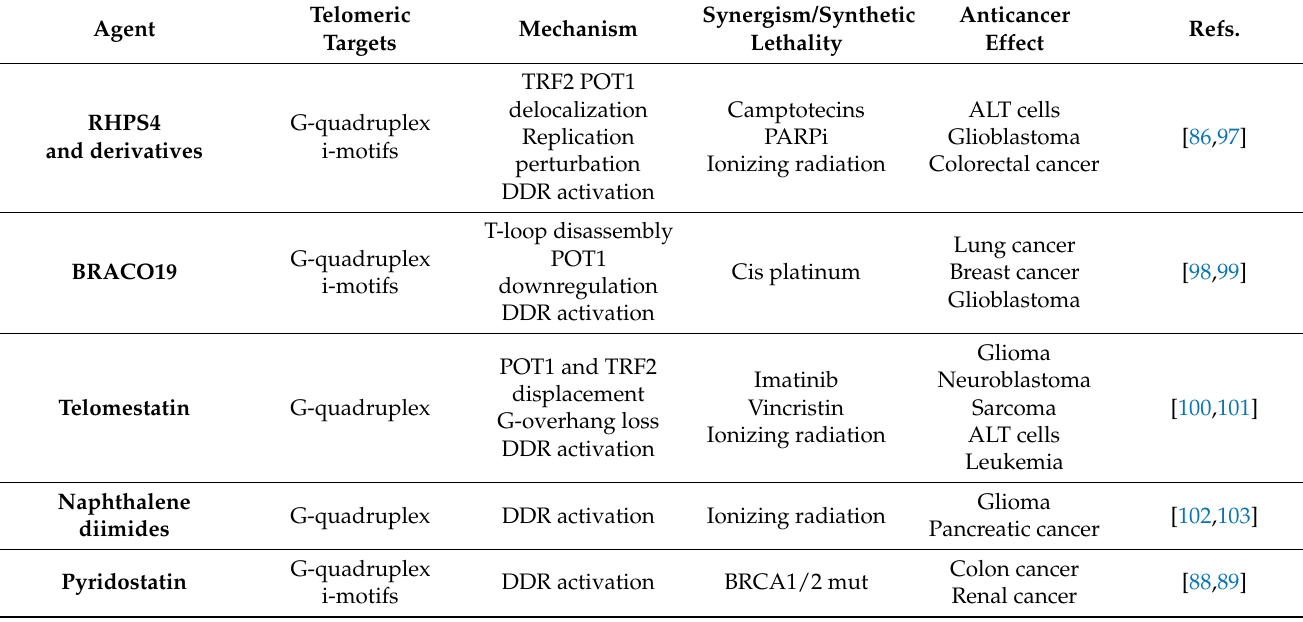
Table 1. Summary of compounds with in cellulo-assessed telomere-targeting activity and their mechanism of